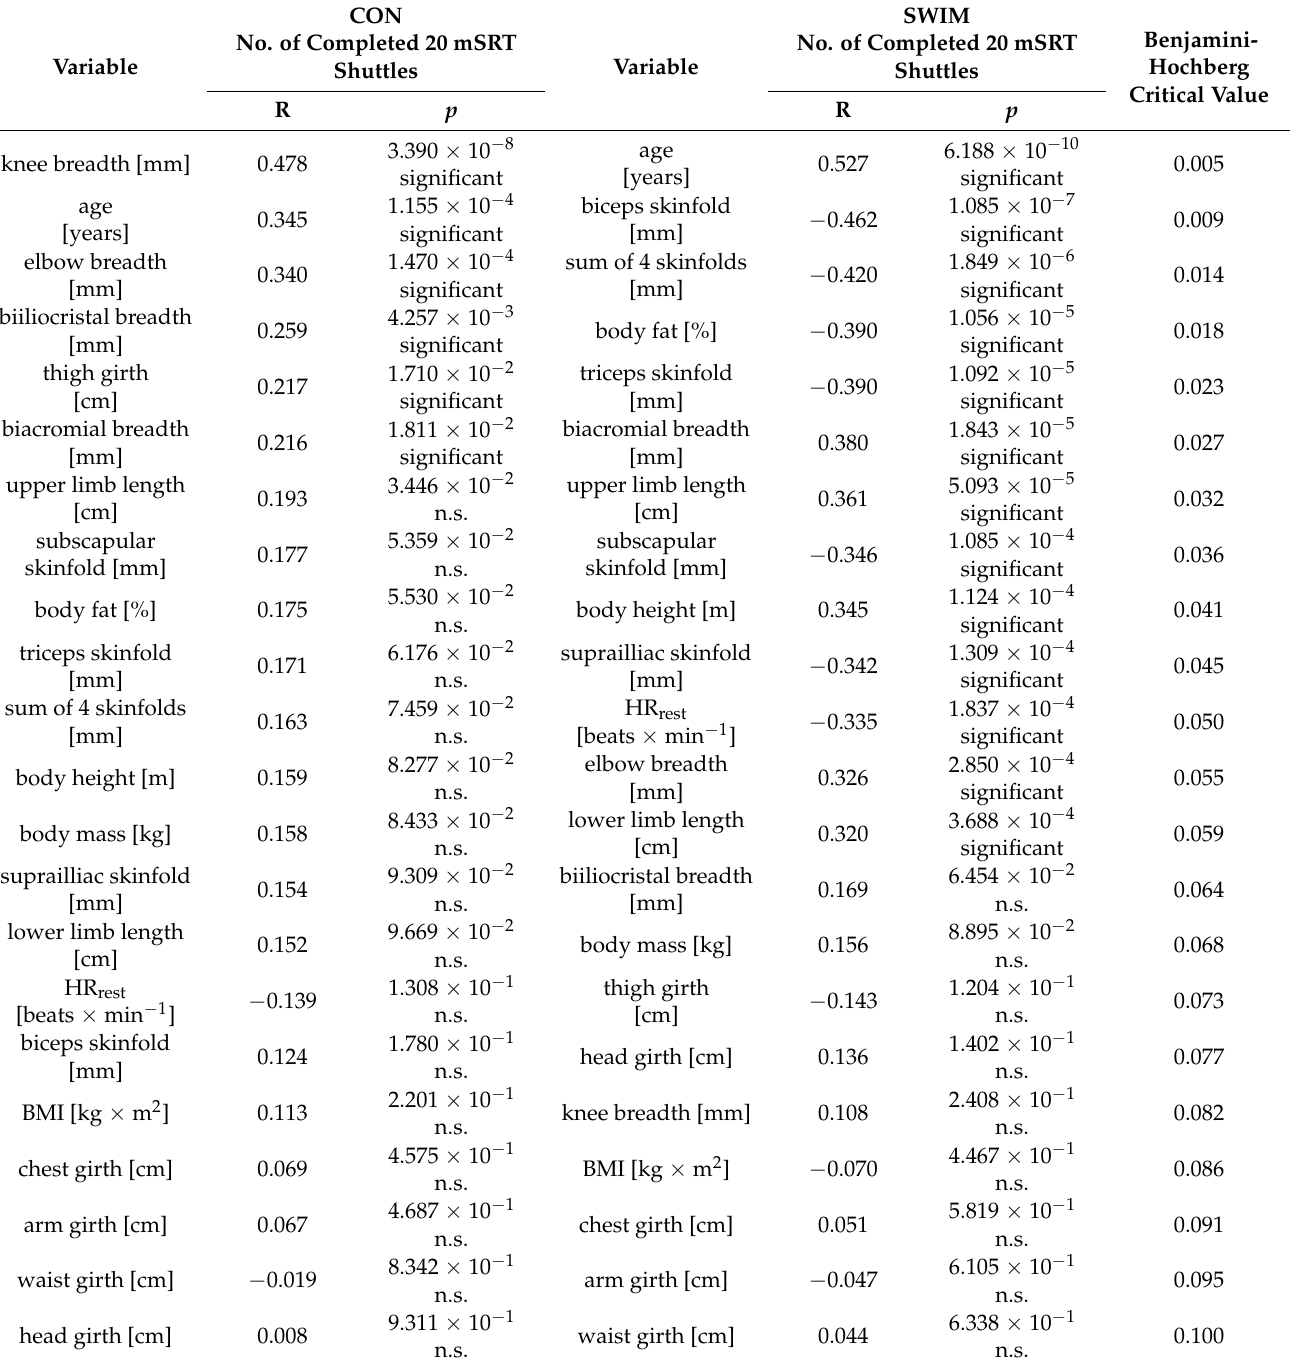
Table 2. Pearson’s correlation coefficients between the number of completed 20 mSRT shuttles and biological variables for the control group (con; n = 120) and the experimental group (swim; n = 120) adjusted for the false discovery rate of